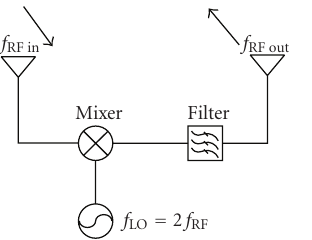
Figure 1: Schematic of the heterodyne technique using an LO at twice the RF frequency.